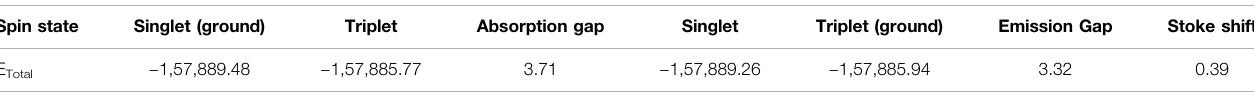
TABLE 2 | The absorption and emission gaps for the Si 20 H 20 (in unit